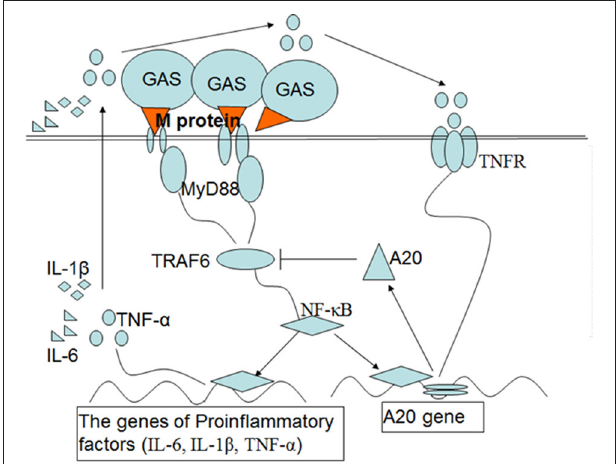
FIGURE 8 | Schematic diagram of the signaling pathways that are postulated to upregulate the expression of A20 and then inhibit inflammatory mediators in macrophages induced by M protein following GAS infection. Upon induction of macrophages by M protein of GAS, NF- κ B is activated through the MyD88 pathway, which induces expression of genes associated with the proinflammatory cytokines IL-1 β , IL-6, and TNF- α . A20 expression depends on activation of NF- κ B and partly on the interaction of TNF- α and TNFR. In turn, A20 targets TRAF-6 to inhibit inflammatory signal pathways, which leads to a reduction in the production of proinflammatory